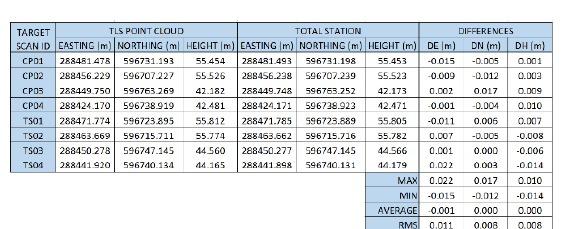
Table 7. Comparison between TLS point cloud data computed by ScanMaster software and Total Station data using